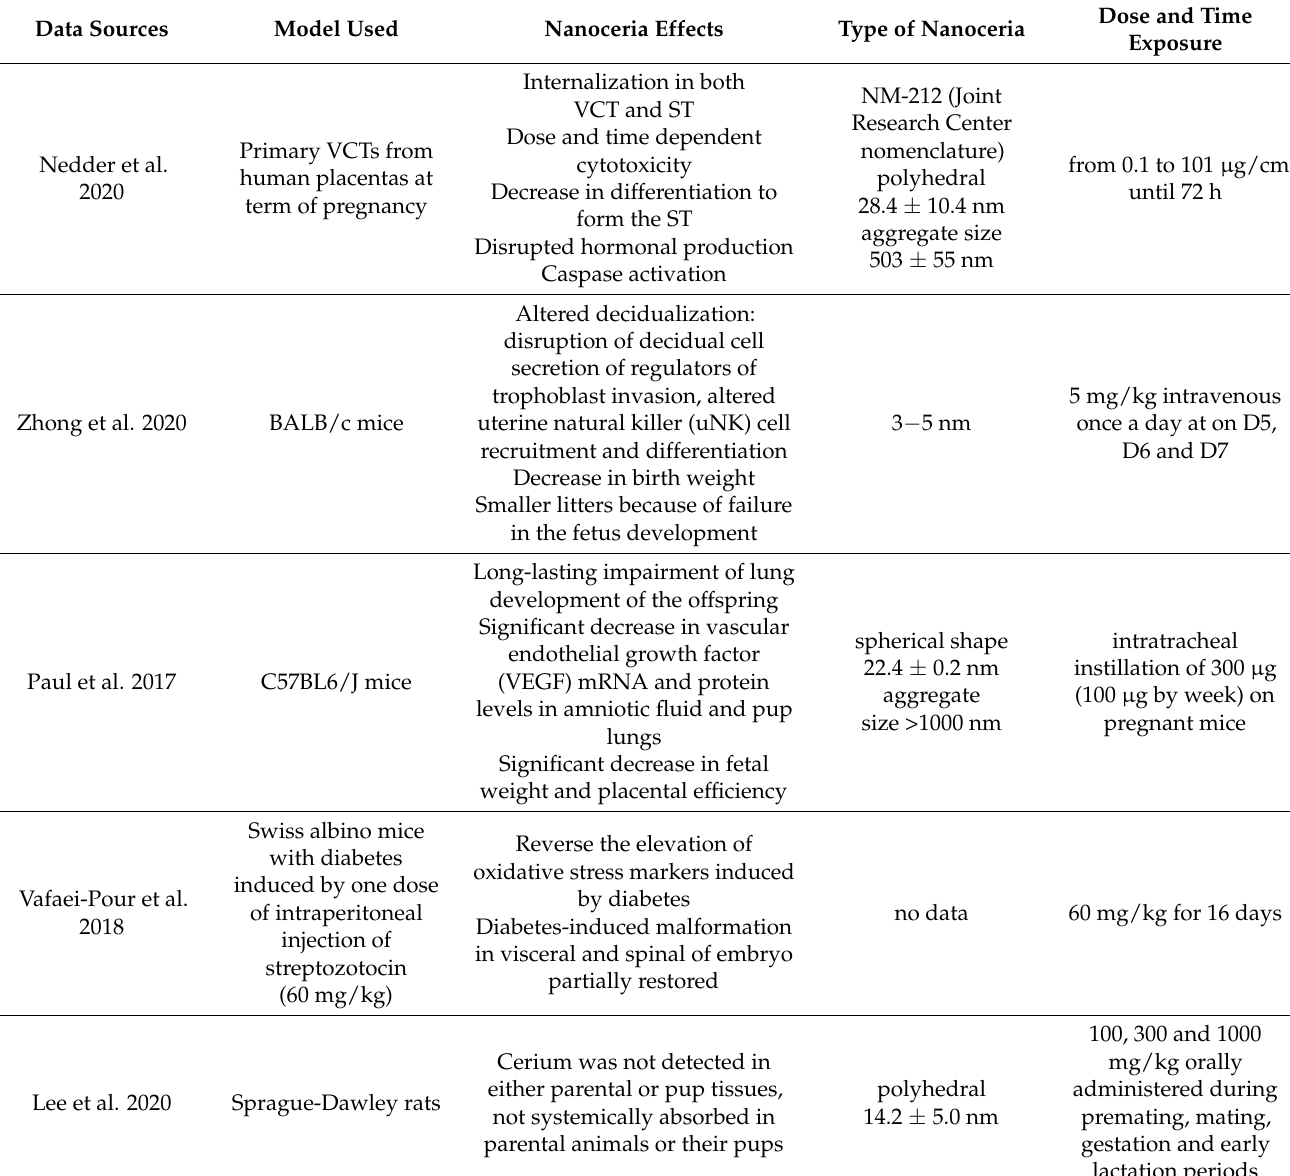
Table 5. Assessment of the impacts of nanoceria on